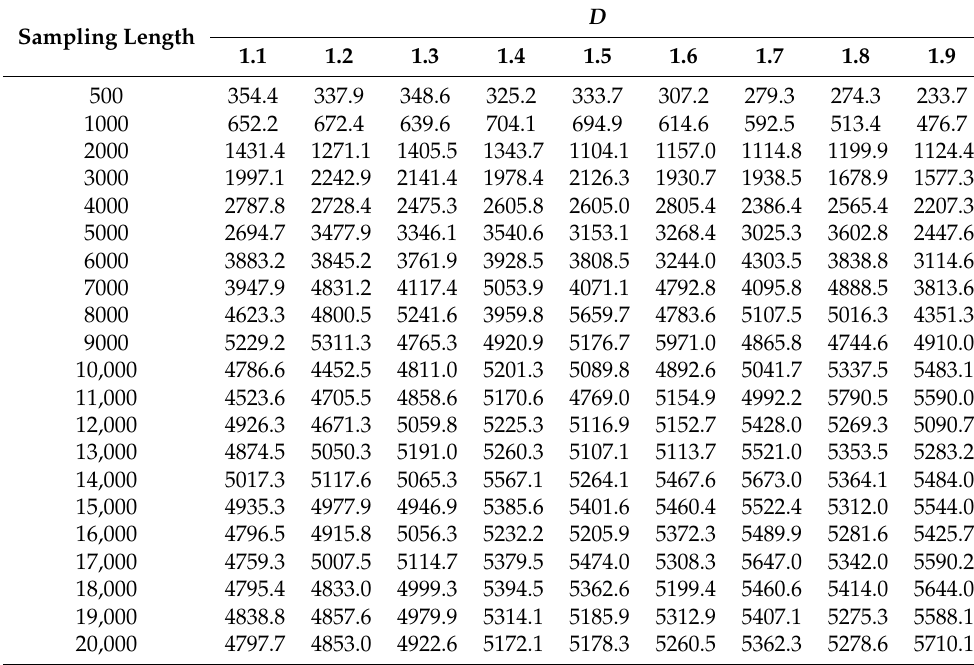
Table A2. Under all sampling lengths and all fractal dimensions, L c of corner points under the condition of 1-order flattening pre-processing.